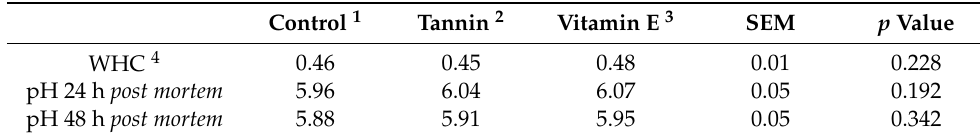
Table 4. Effect of chestnut tannins and vitamin E on the water holding capacity and pH of the breast meat of broiler chickens.